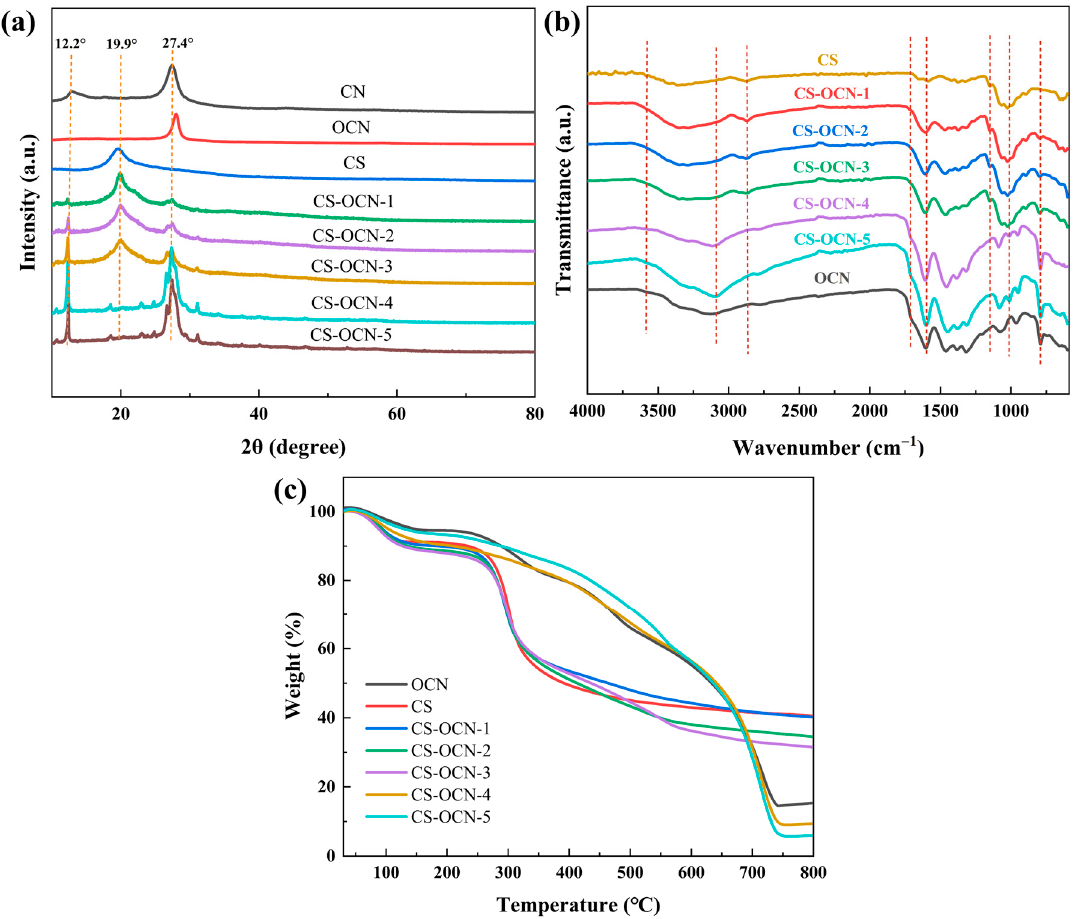
Figure 2. ( a ) XRD pa tt erns, ( b ) FT-IR spectra and ( c ) TGA curves of OCN and